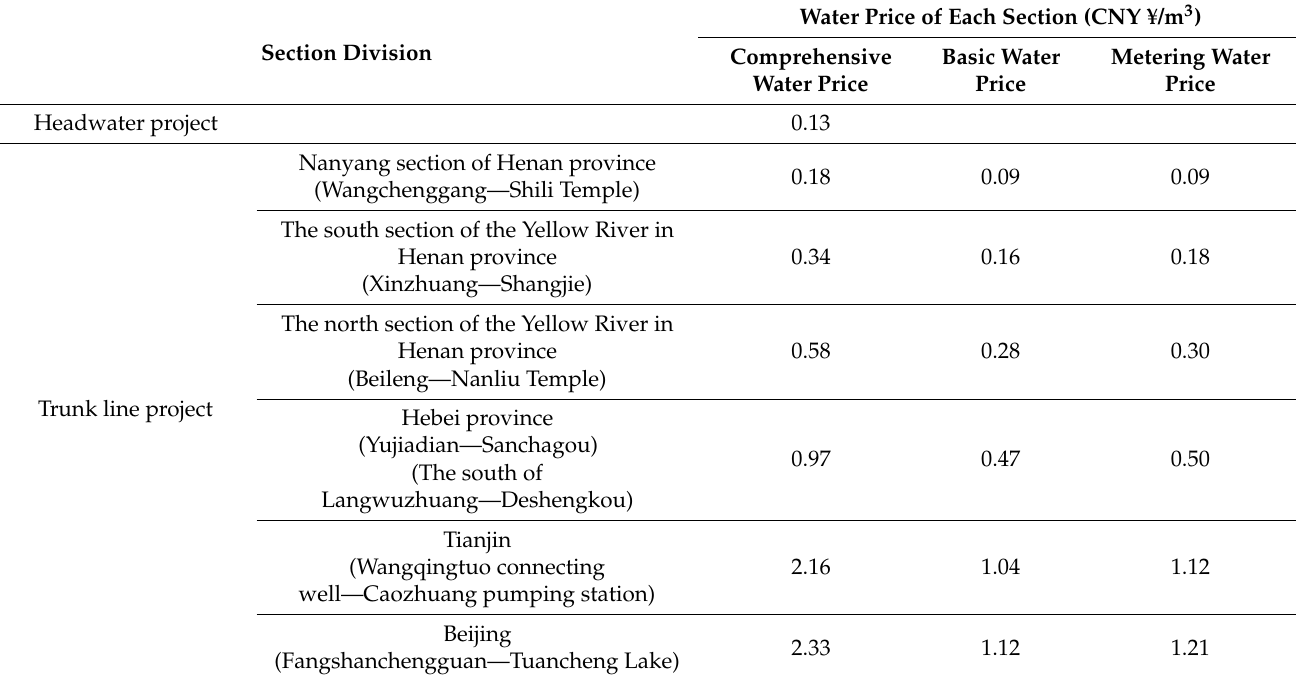
Table 1. The outlet water price in the central line project of